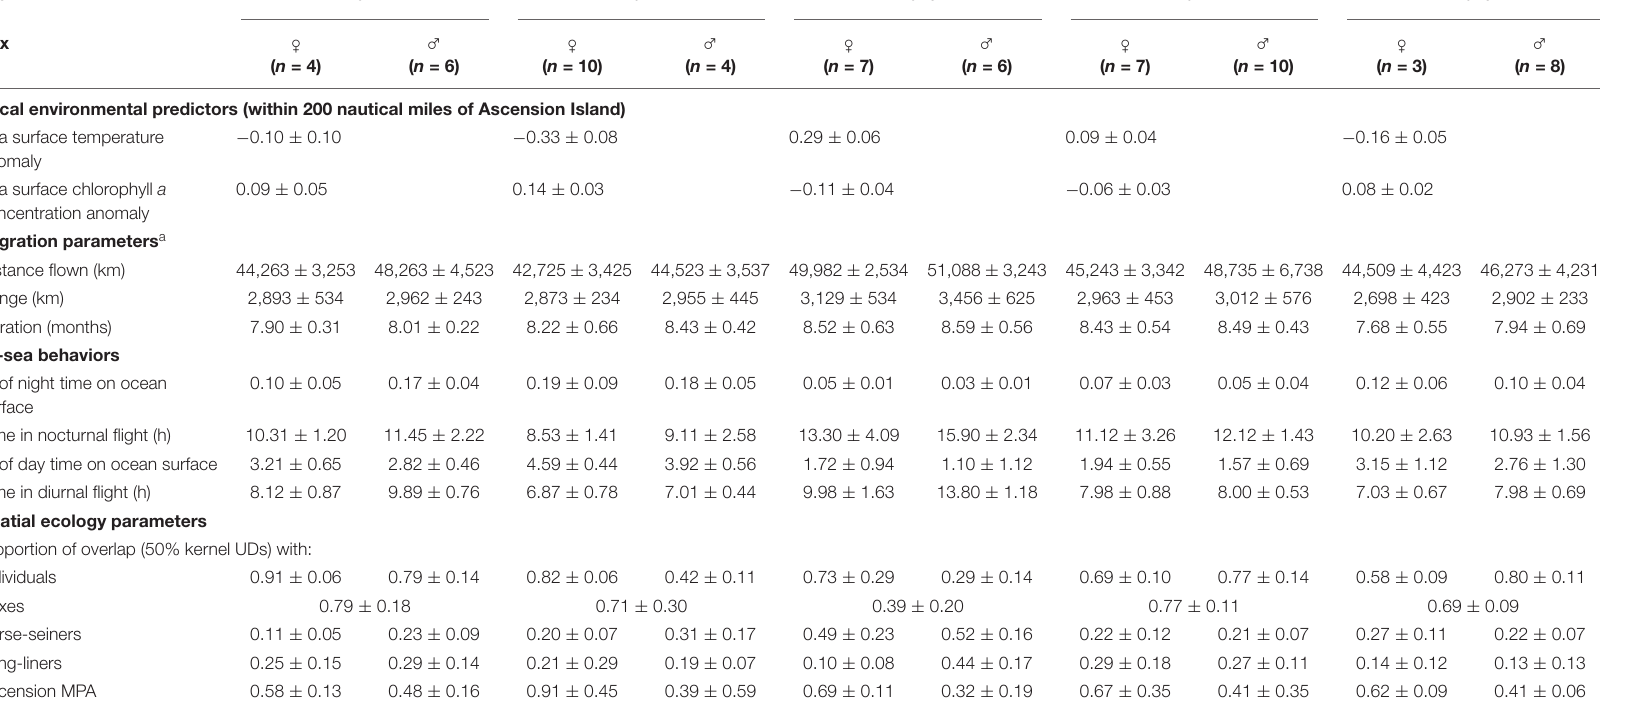
Values represent means ± 1 SD. a Only migrations over the entire non-breeding period are included. This results in reduced sample sizes in 2012